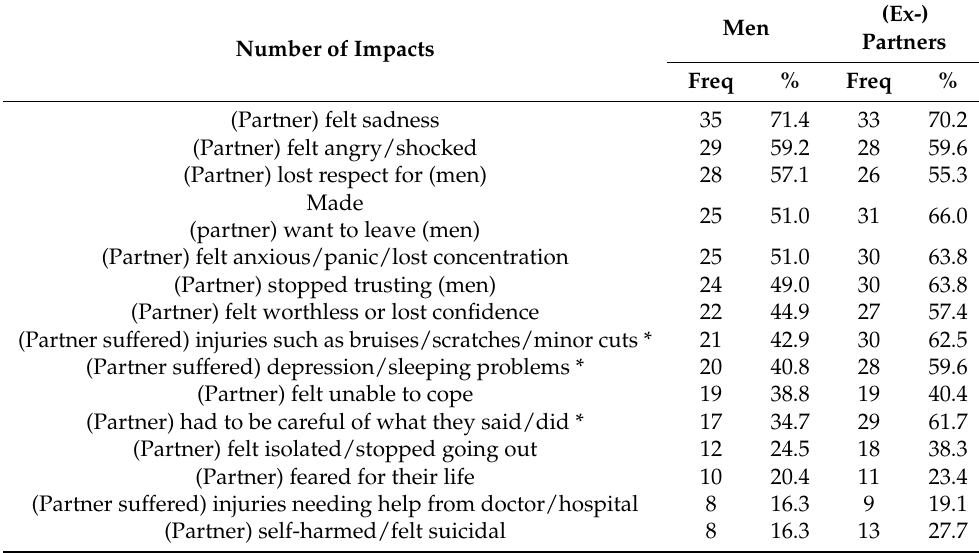
Table 7. Frequency of impacts reported by men and (ex-) partners.